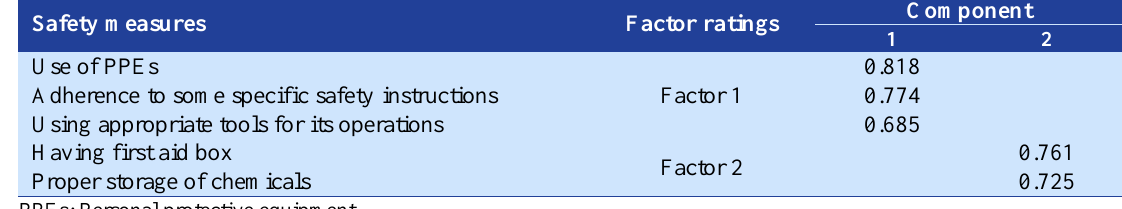
Table 6. Rotated component matrix for safety measures Safety